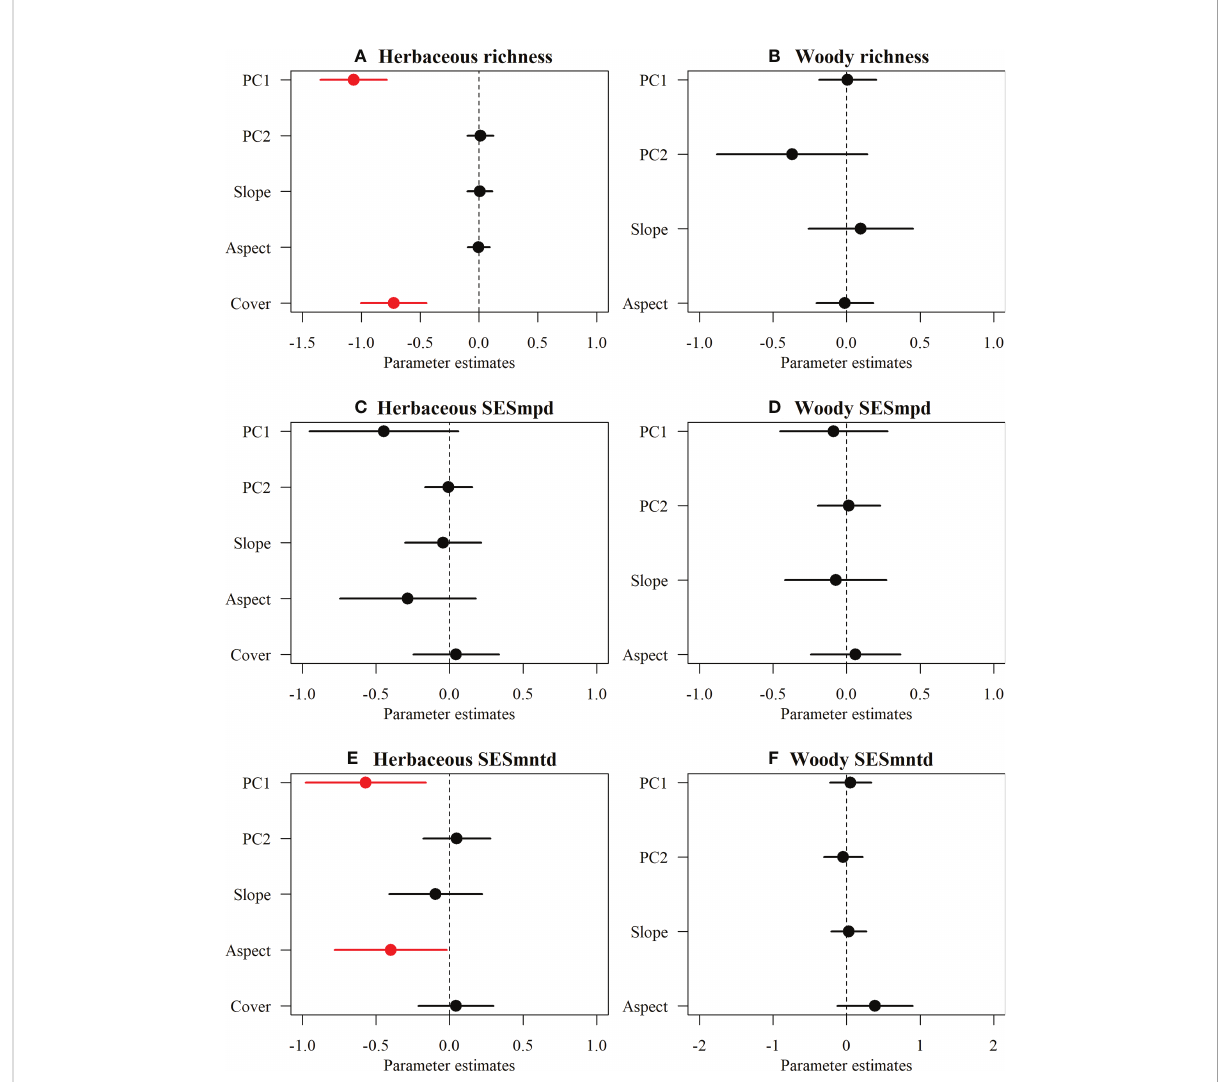
FIGURE 4 The effects of multi-dimensional variables on the species richness and phylogenetic structure (SESmpd, SESmntd) of plant communities of herbaceous (A, C, E) and woody (B, D, F) . The parameter estimates (standardized model-averaged coef fi cients for variables) and the associated 95% con fi dence intervals are shown. Coef fi cient > 0 represents a positive effect, while coef fi cient < 0 indicates a negative effect (red). All predictors were centered and scaled to make the coef fi cients directly